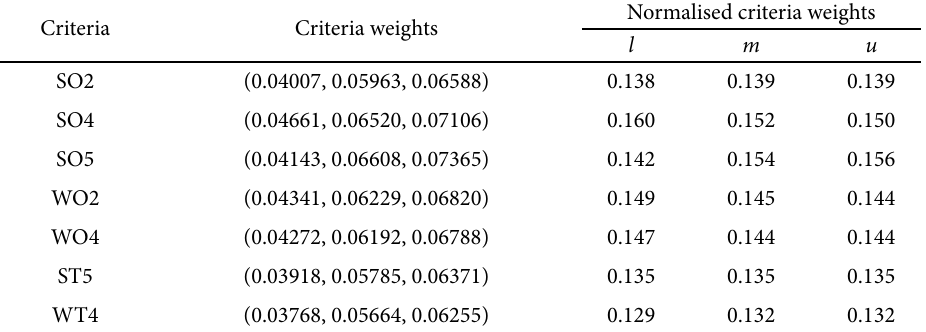
Table 8. The fuzzy decision matrix and fuzzy weights of Partners’ criteria